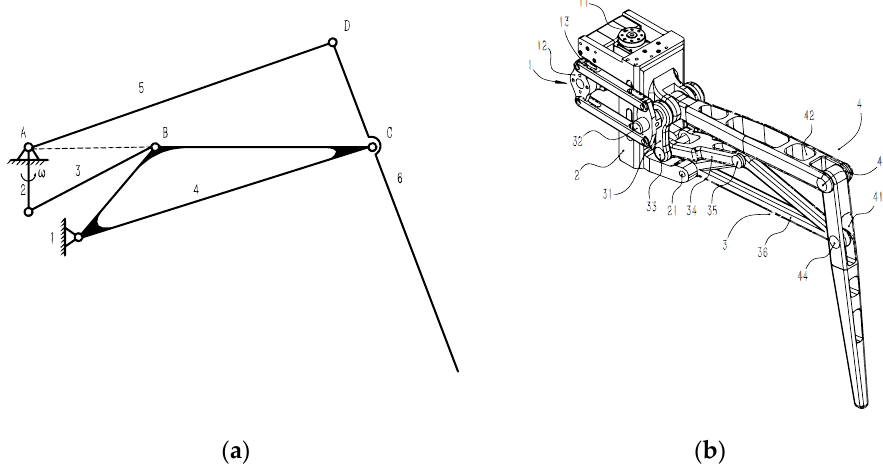
Figure 1. ( a ) The skeleton of the leg mechanism. ( b ) The leg mechanism diagram.